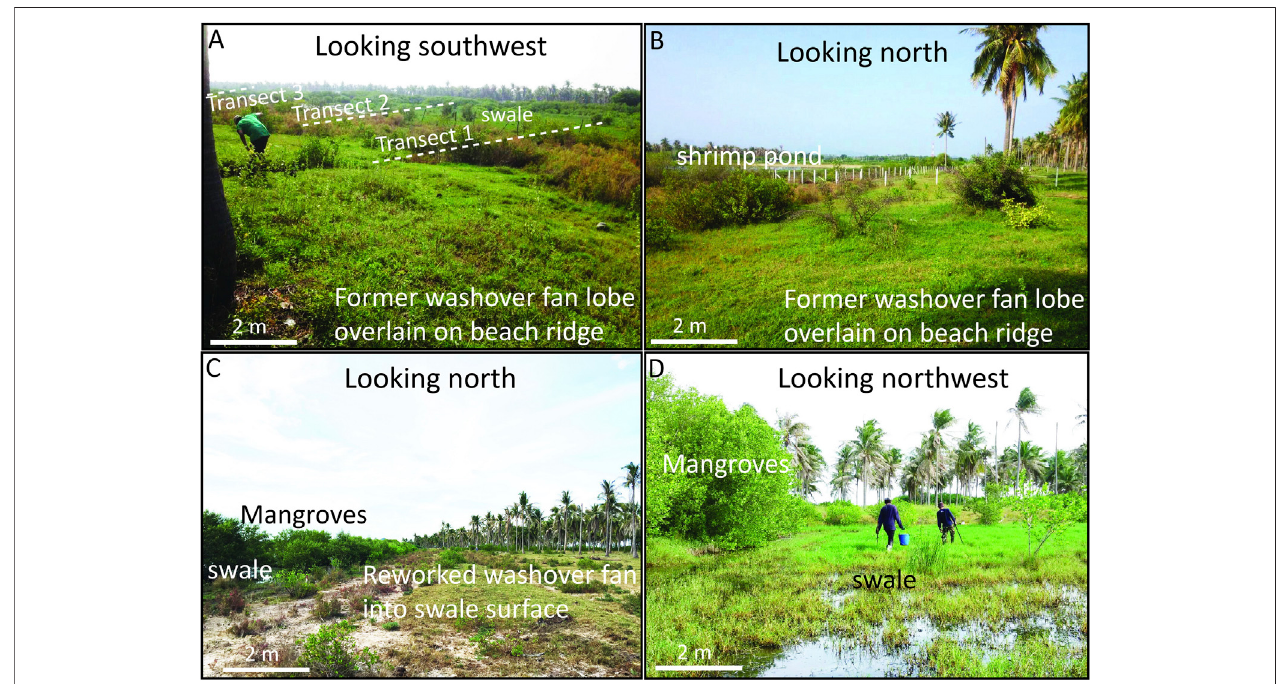
FIGURE2| Photographsofthestudysiteshowing (A) thethreetransectlinesacrossthebeachridgewhereaformer washoverfanlobewasoverlainontheshore- normal beach ridge, (B) shrimp ponds within the swale in the north (C) trace of reworked sand from washover deposits overtopping onto the swale surface during the rainy season, and (D) the condition of the wet swale when the gouge cores were drilled.